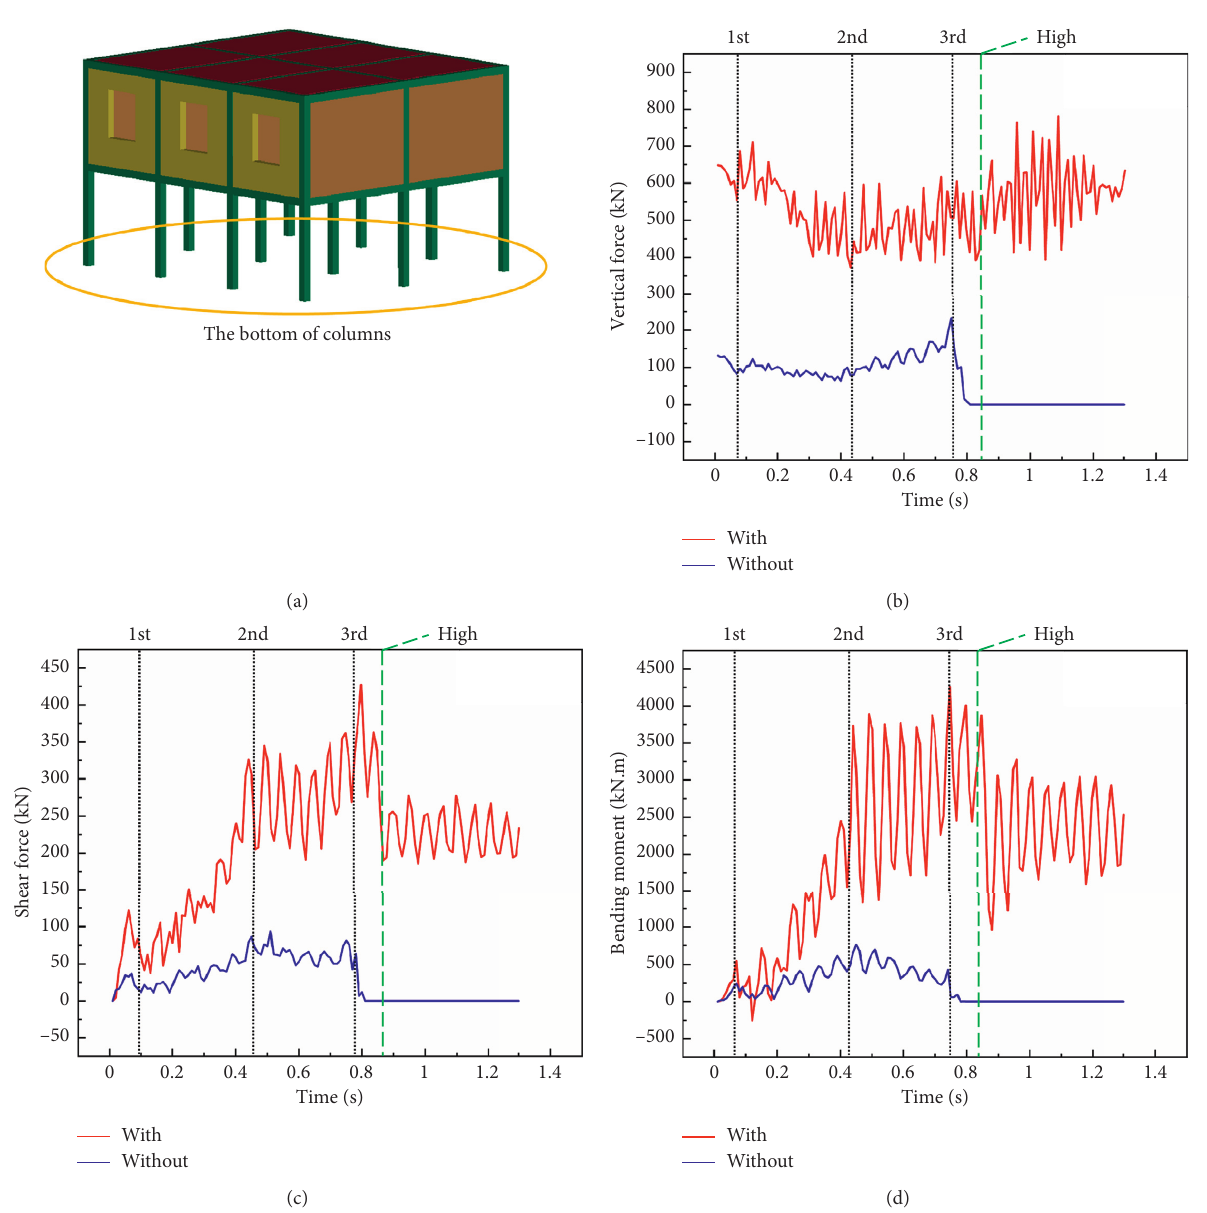
Figure 13: Comparisons between the scenarios of s � 0 and s � 1 ( h � 3.2 m, v � 12.0 m/s): (a) total vertical force, (b) total shear force, and (c) total bending moment at the bottom of